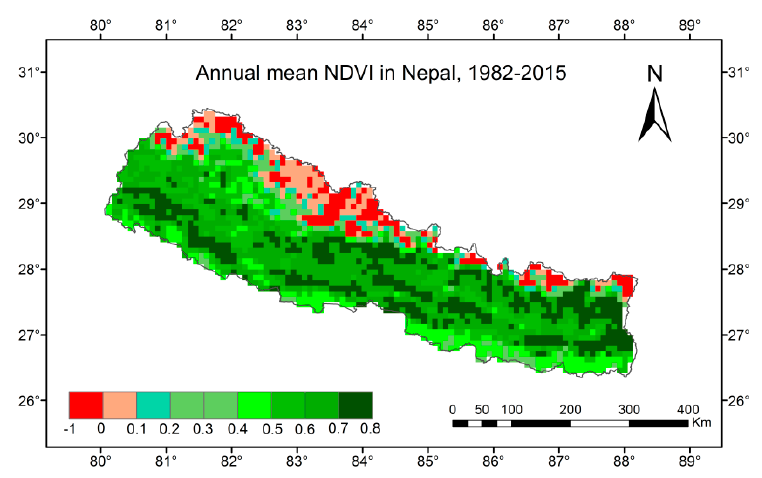
Figure 3. The annual mean NDVI distributions derived from monthly AVHRR NDVI in Nepal, 1982–2015.